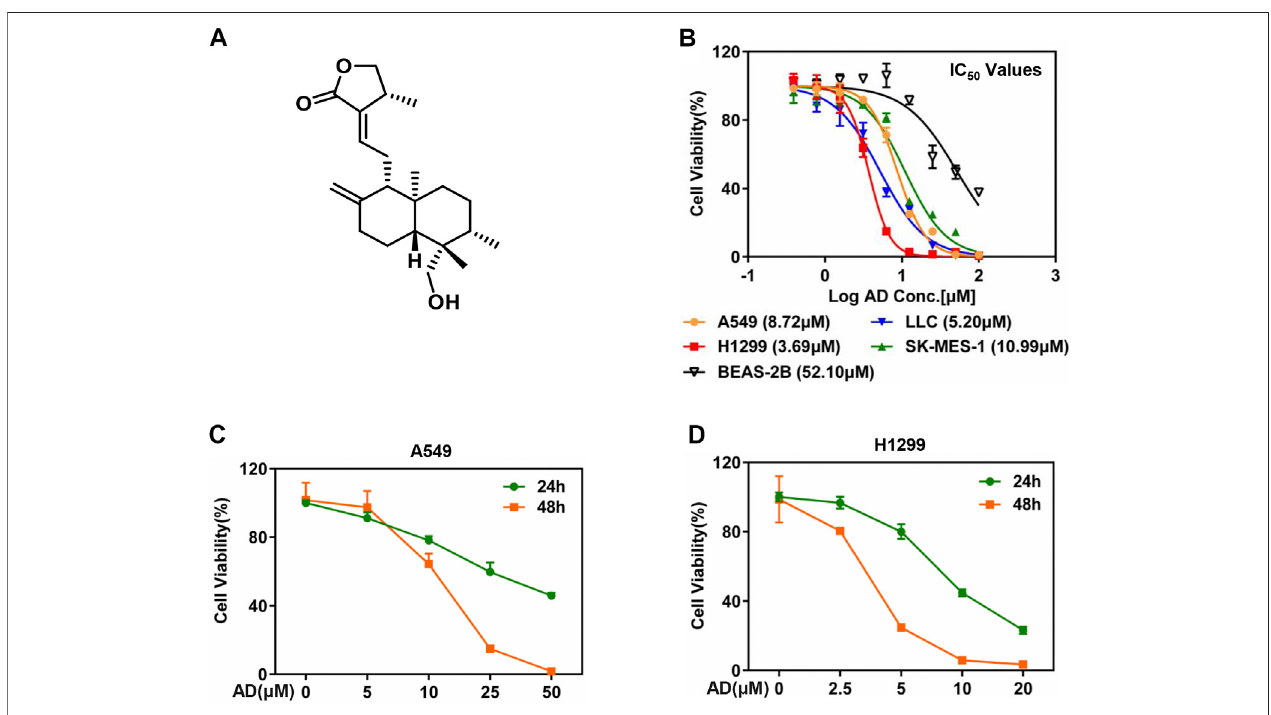
FIGURE 1 | Andrographolide inhibited the proliferation of lung cancer cells. (A) The chemical structure of AD. (B) Cells were seeded in ATPlite plates in triplicate, 2000 cells per well, cultured overnight, and treated with 1 ‰ DMSO or various concentrations of AD (100, 50, 25, 12.5, 6.25, 3.13, 1.56, and 0.78 μ M) for 48 h. The ATPlite cell viability assay was used to determine the half-maximal inhibitory concentrations IC 50 of A549, H1299, SK-MES-1, LLC, and BEAS-2B cells, respectively. (C – D) CellswereseededinATPliteplatesintriplicate,2000cellsperwell,culturedovernight,andtreatedwith1 ‰ DMSOorindicatedconcentrationsofADfor24 h and 48 h, followed by the ATPlite cell viability